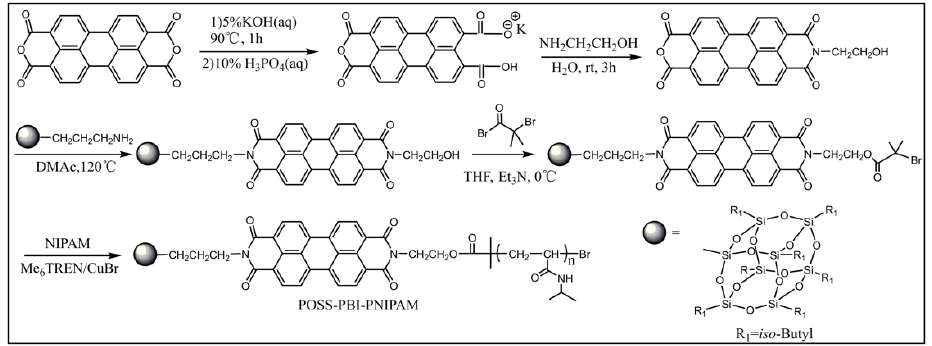
Figure 5. Synthetic procedure of the PBI-bridged amphiphilic polymer POSS-PBI-PNIPAM [74].